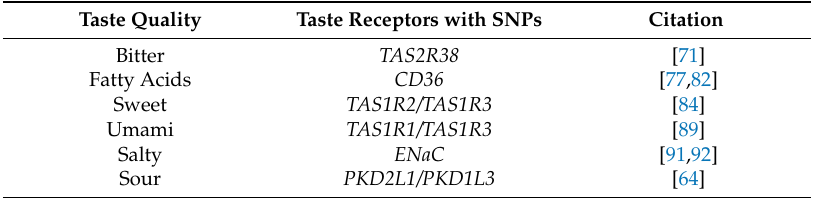
Table 4. Taste receptor genes with single nucleotide polymorphisms (SNPs) and their corresponding taste